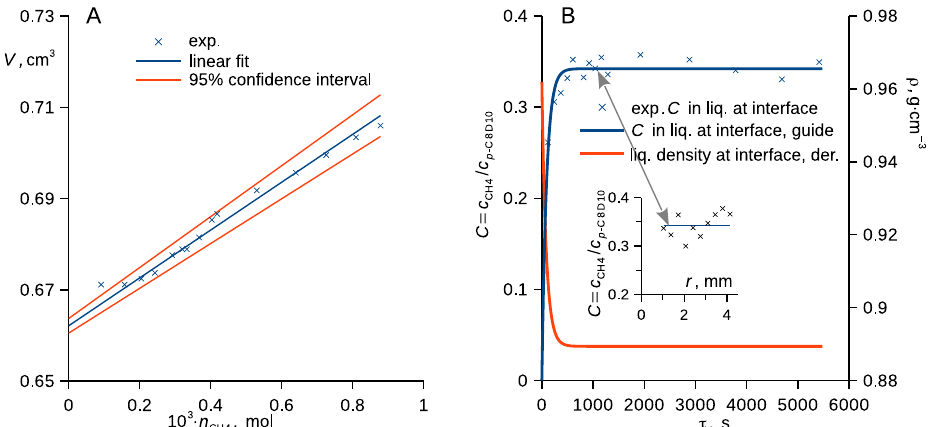
Figure 2. ( A ) Plot of volume of the liquid in the cell against the mole amount of absorbed methane is shown together with the linear fit and its confidence interval. ( B ) Time-evolution of the measured radius-averaged relative concentration of methane at the phase interface is shown with an empirical model (the blue curve is the plot of C ∞ − C ∞ ⋅ exp[− τ / (91.1 s)]). The red curve is the derived model of density, insert shows the relative concentration of methane at the interface with respect to the cell radius for time 1043 s. Both examples are for supercooled perdeuterated p -xylene ( p -C 8 D 10 ) at 7.0 ± 0.2 °C initially exposed to methane at 100.4 ± 0.2